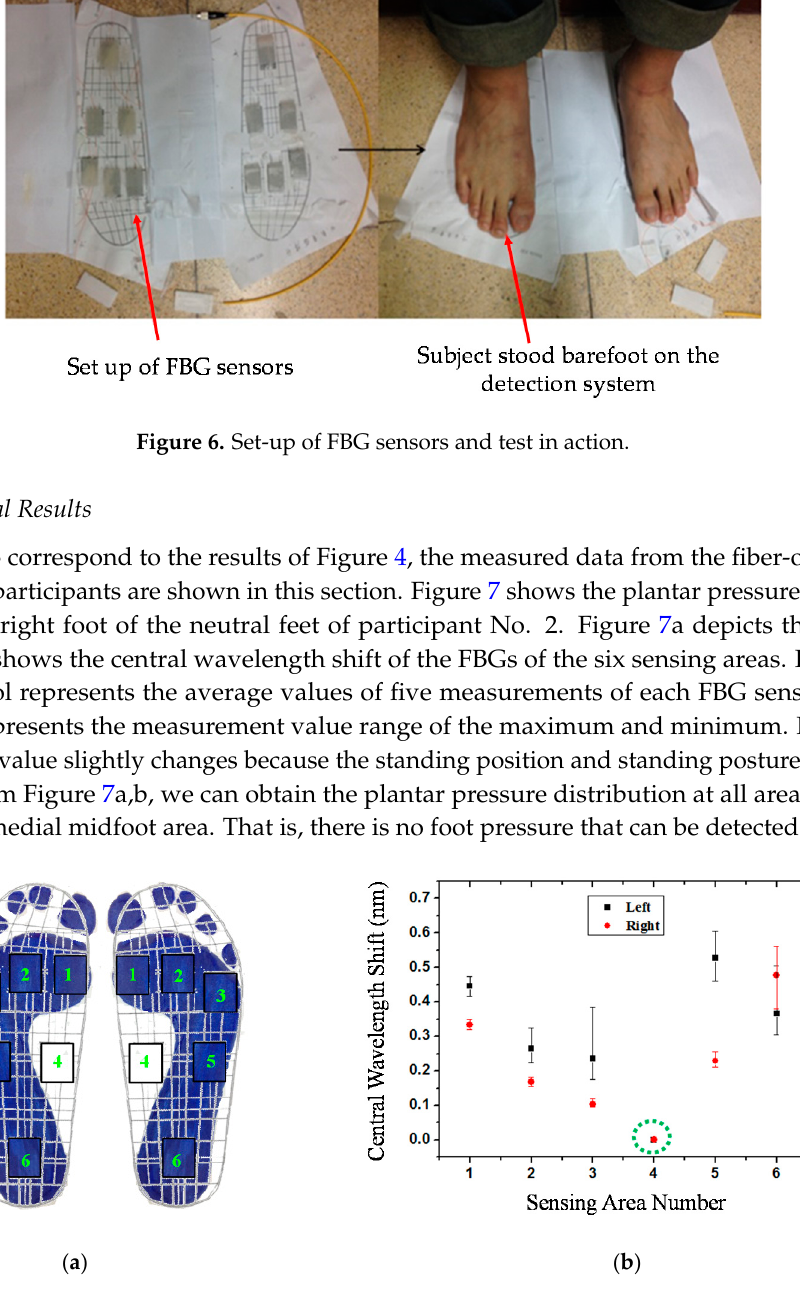
Figure 7. The plantar pressure distribution of the neutral feet of participant No. 2: ( a ) Footprint; ( b ) central wavelength shift as a function of sensing area number.